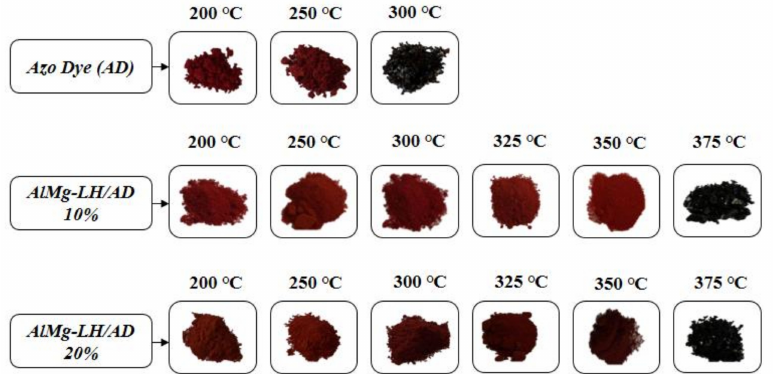
Figure 11. Color changes of azo dye, AlMg − LH/AD 10%, and AlMg − LH/AD 20% powders after thermal aging at different temperatures.